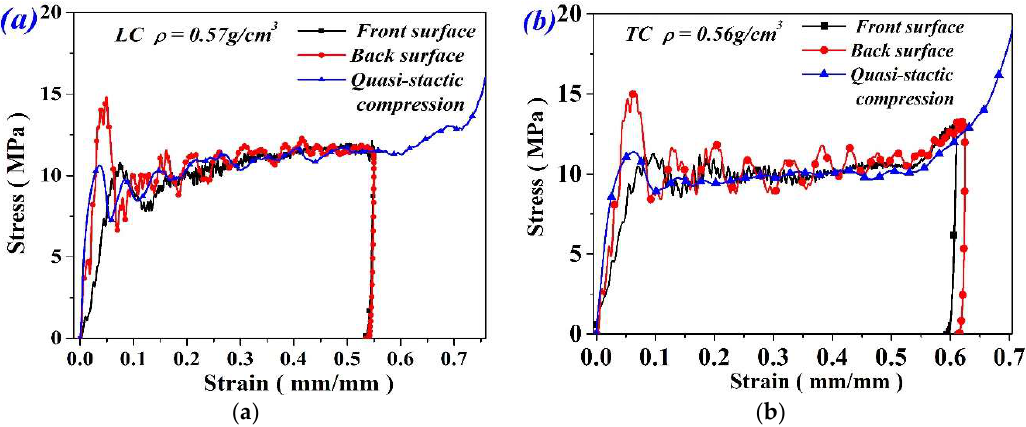
Figure 5. Validation of stress equilibrium for specimens under ( a ) LC and ( b ) TC.